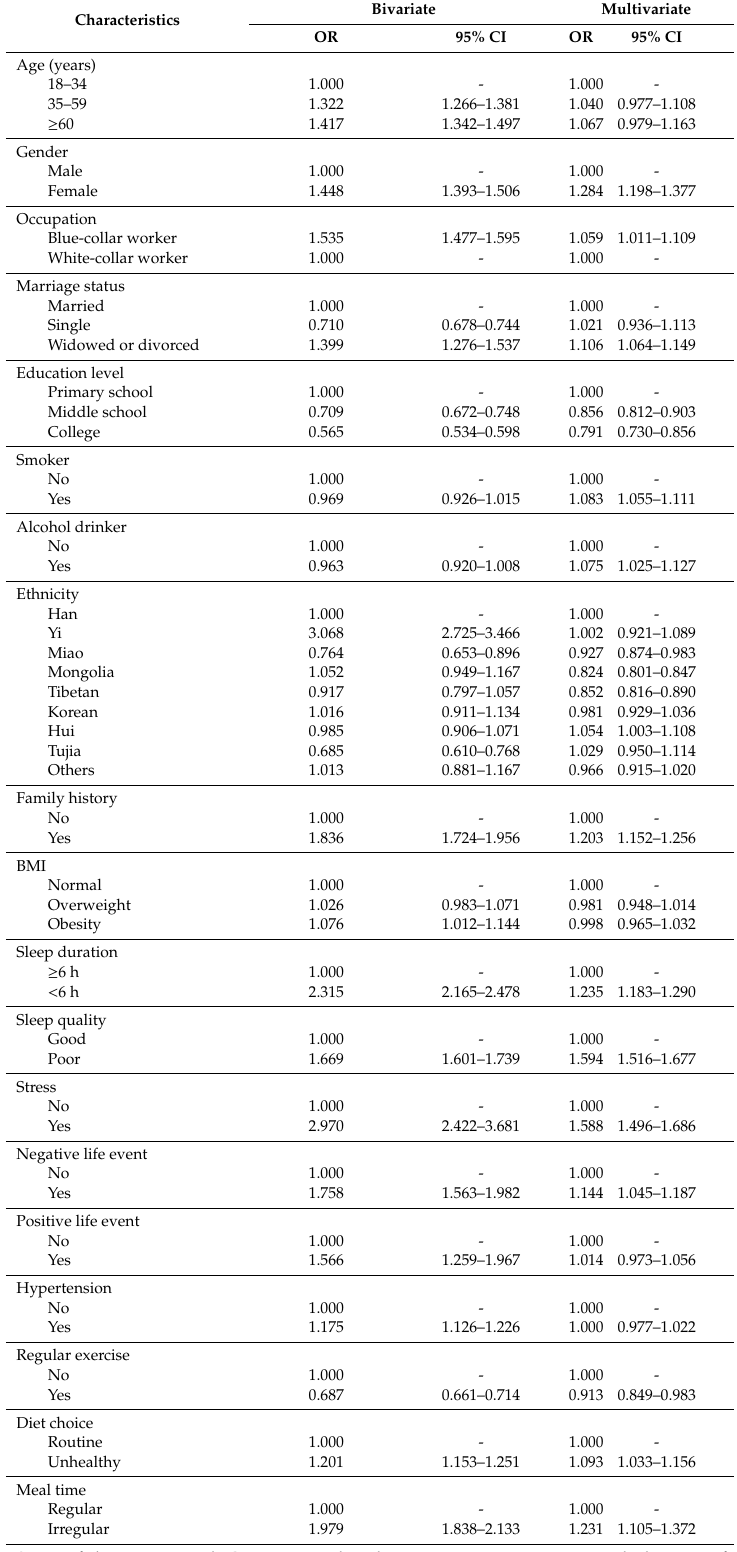
Table 3. Risk factors associated with suboptimal health based on a multi-level GEE